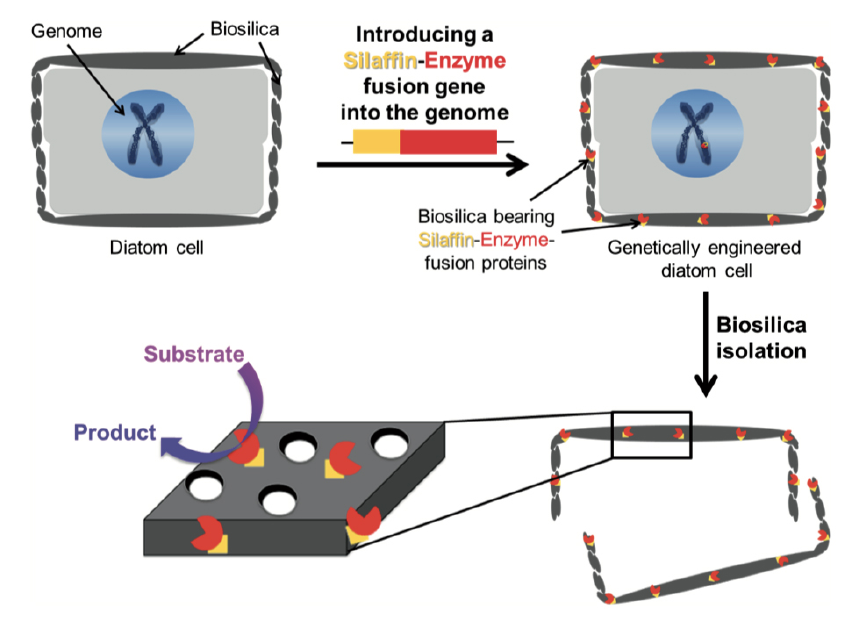
Figure 11. Schematic of the LiDSI method. Reproduced with permission from Ref.